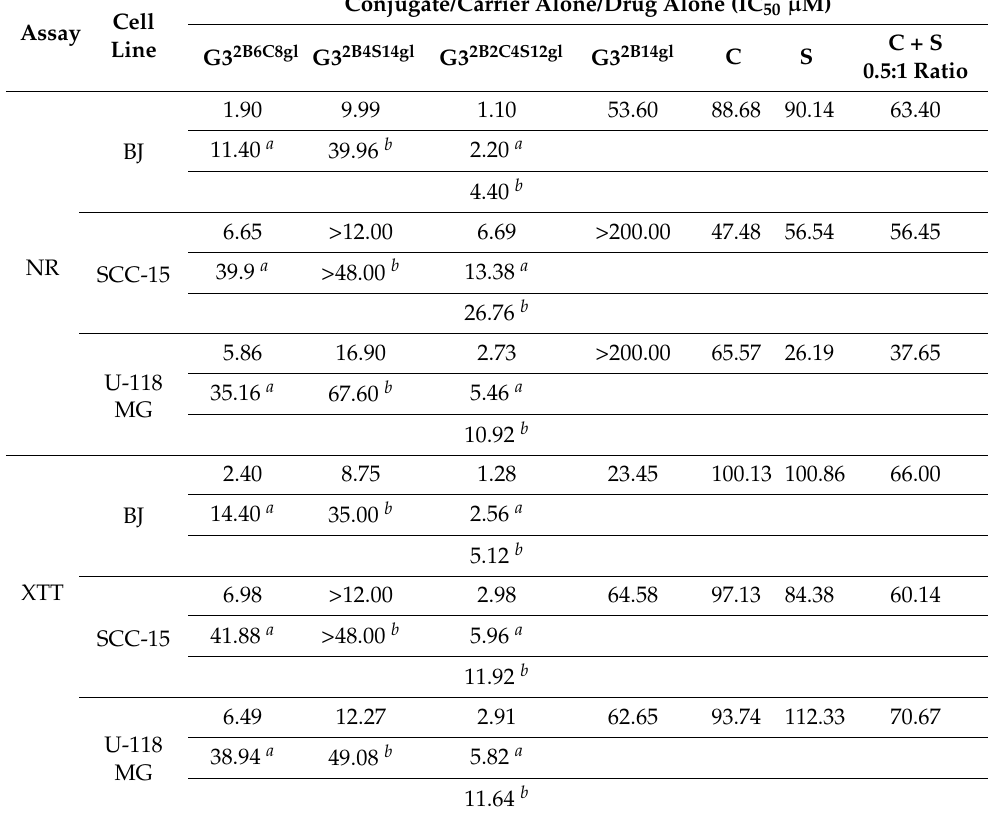
Table 2. Cytotoxicity of investigated repurposed drugs alone and their conjugates with G3 2B14gl estimated for the normal BJ and cancer SCC-15 and U-118 MG cells, expressed as half maximal inhibitory concentration (IC 50 ) in micromolar concentration (medians). Data were estimated with NR and XTT assay after 24 h incubation and calculated with AAT Bioquest IC 50 calculator [31]. a —concentration of introduced C, b —concentration of introduced